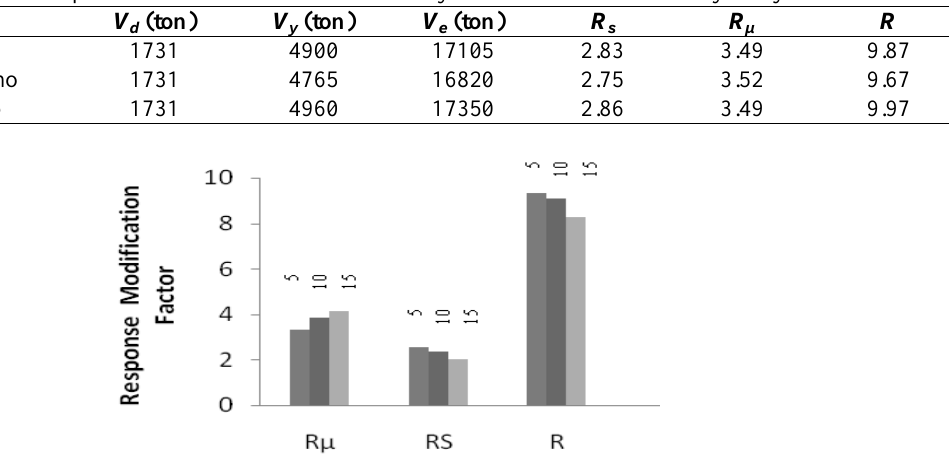
Fig. 8. Response modification factors due to increasing height of